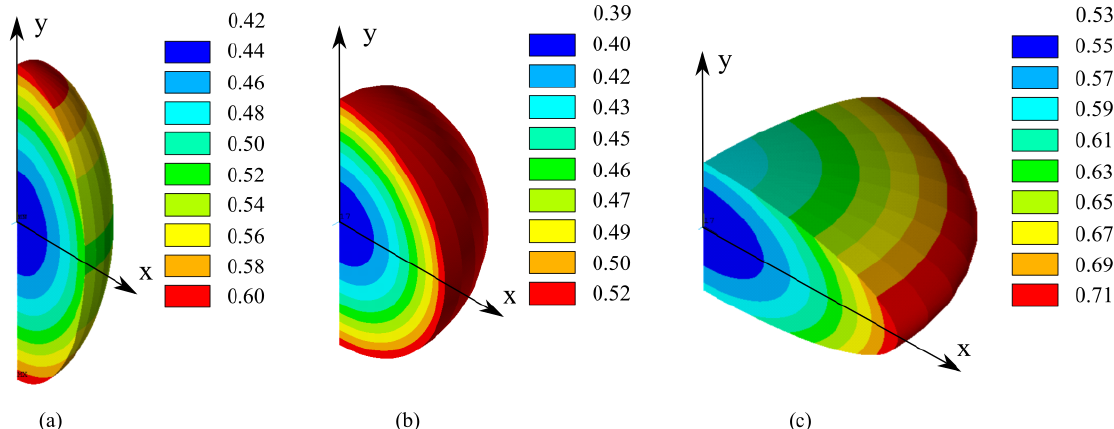
Figure 9. Normalized concentration distribution (˜ c = c / c max ) in sphere, α = 1 ( b ) and in ellipsoids, α = 0.5 ( a ) and α = 3.5 ( c ). Chemical and mechanical properties are listed in Table 2: lithium flux is 1 A/m 2 and simulation time is 1000